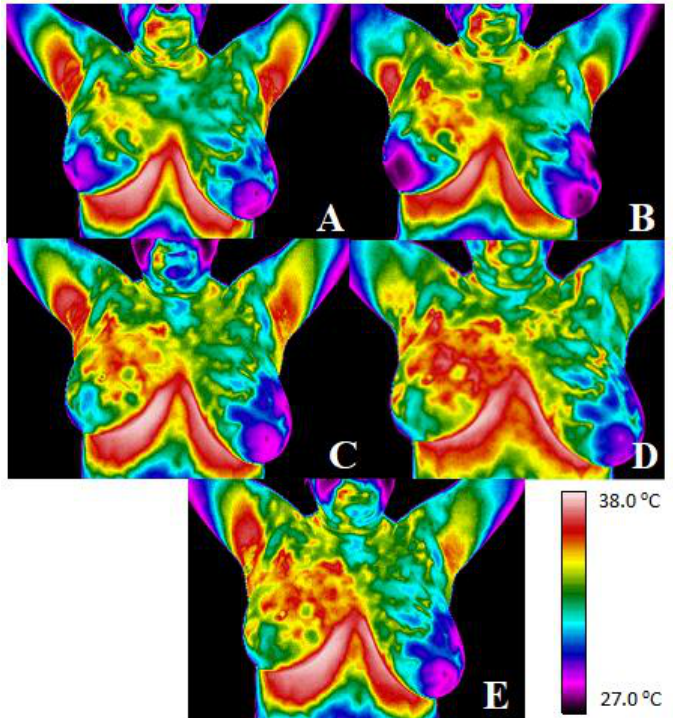
Figure 2. Thermograms of an exemplary patient taken before radiotherapy (thermogram ( A )), after the first week of treatment (thermogram ( B )), after the second week of treatment (thermogram ( C )), after the third week of treatment (thermogram ( D )) and after the fourth week of treatment (thermogram ( E )). of treatment and the pre-radiotherapy temperature values were calculated and collected. Table 1. Temperature change in PTV area for 10 exemplary patients, difference between the third week and mean temperature before radiotherapy.